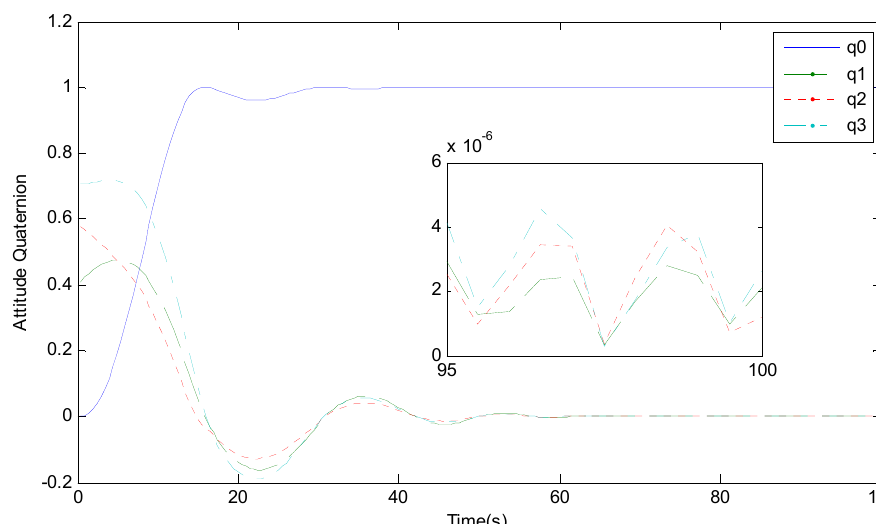
Figure 18. Curve of attitude quaternion.